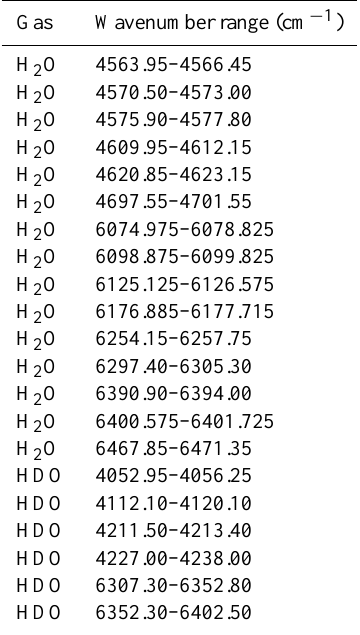
Table 1. List of the TCCON H 2 O and HDO retrieval